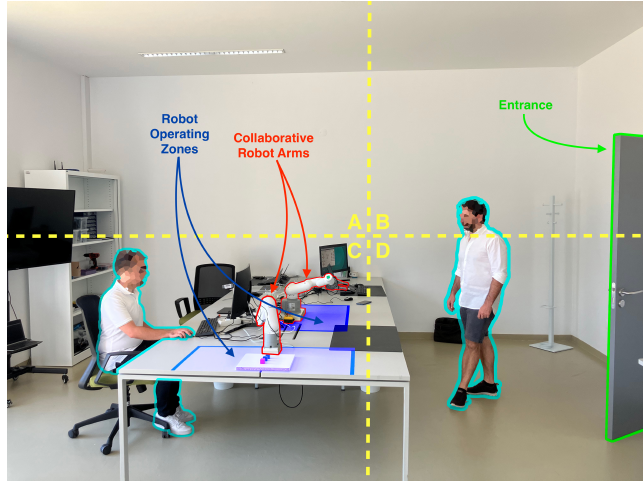
Figure 10. Setup of the experimental testbed in a research